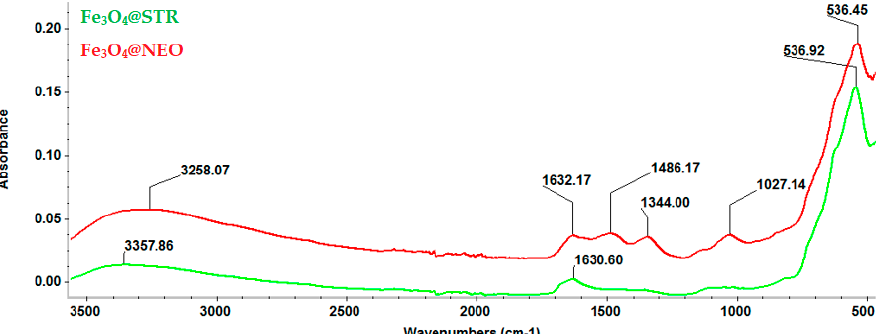
Figure 3. FT-IR spectra of Fe 3 O 4 @STR and Fe 3 O 4 @NEO nanoparticles.